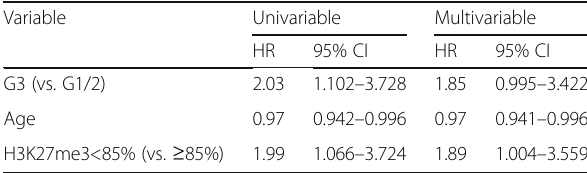
Table 4 Univariate and multivariate analysis regarding disease